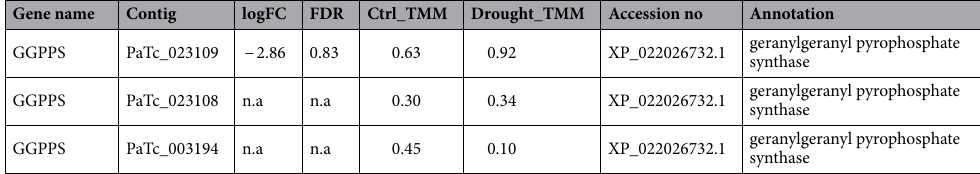
Table 2. Identification and expression analysis of rubber biosynthesis associated genes.